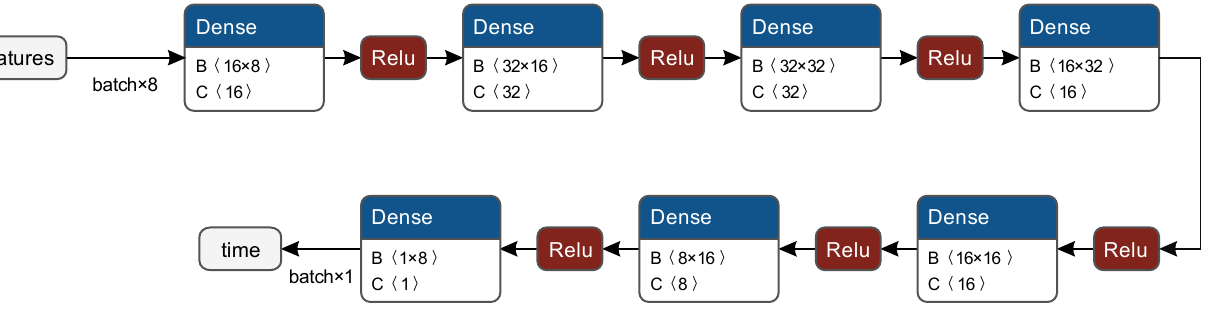
Figure 1. Neural network architecture.